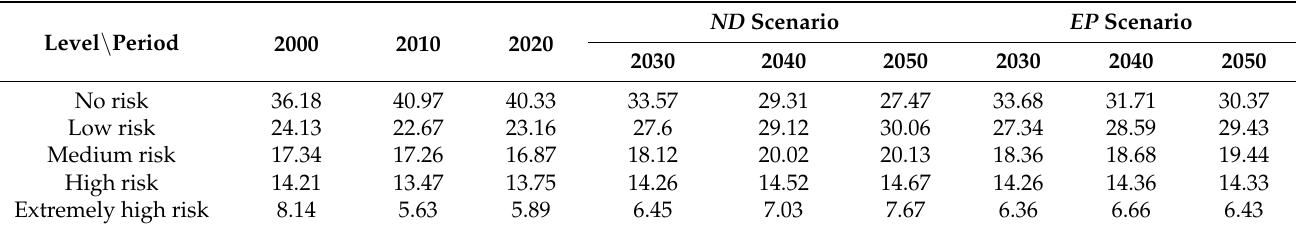
Figure 4. Distribution of hot spots of LERI from 2000 to 2050. Table 2. Statistical table of LER ’s proportion of each grade from 2000 to